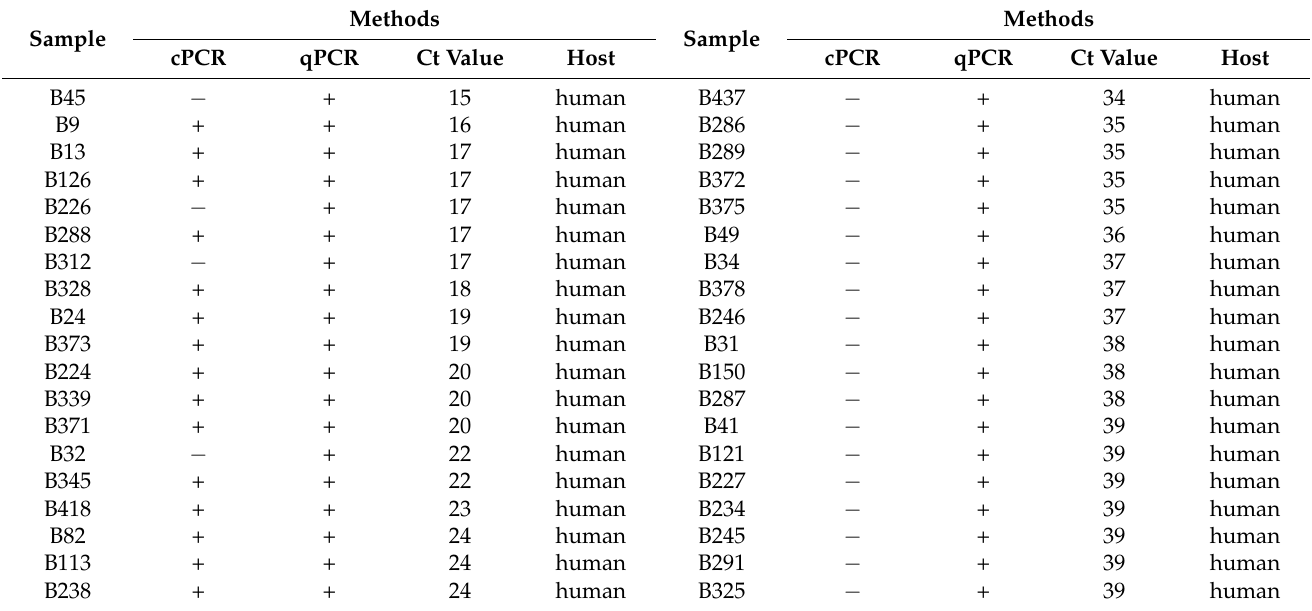
Table 3. Summary of qPCR-positive human and animal samples (N = 90) for Dientamoeba fragilis with Ct values and comparison with conventional PCR (cPCR)